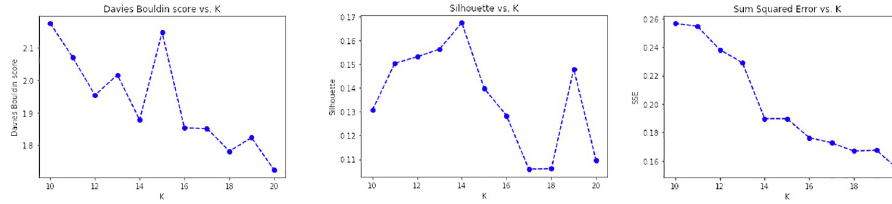
Fig 20. Validation results obtained for CONF-3.